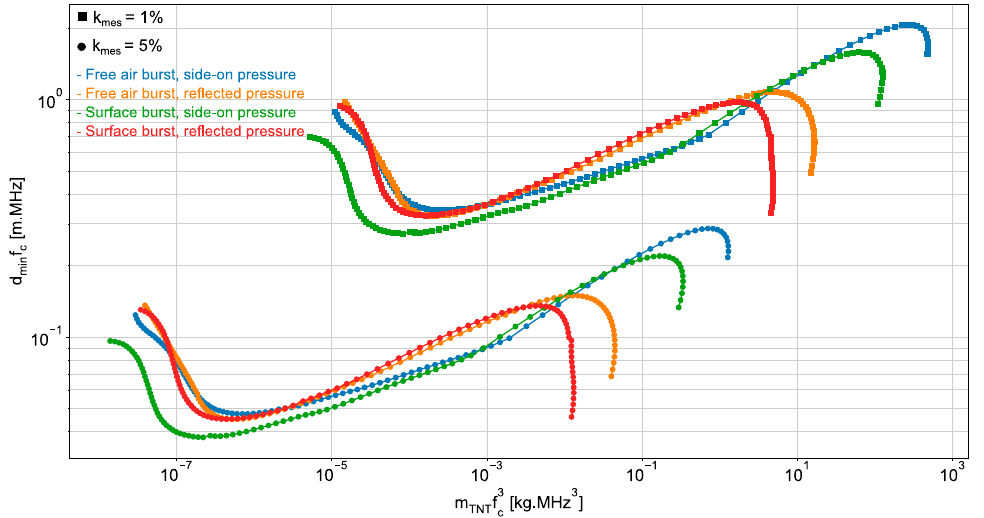
Figure 5. 𝑑 (cid:3040)(cid:3036)(cid:3041) 𝑓 (cid:3030) as a function of 𝑚 (cid:3021)(cid:3015)(cid:3021) 𝑓 (cid:3030)(cid:2871) where 𝑑 (cid:3040)(cid:3036)(cid:3041) denotes the minimal distance between the Figure 5. d min f c as a function of m TNT f 3 c where d min denotes the minimal distance between the sensor sensor and explosive load of equivalent TNT mass 𝑚 (cid:3021)(cid:3015)(cid:3021) which is required to estimate the over- and explosive load of equivalent TNT mass m TNT which is required to estimate the overpressure pressure peak magnitude with the estimation accuracy 𝑘 (cid:3040)(cid:3032)(cid:3046) of 1% (square marker) or 5% (point peak magnitude with the estimation accuracy k mes of 1% (square marker) or 5% (point marker).